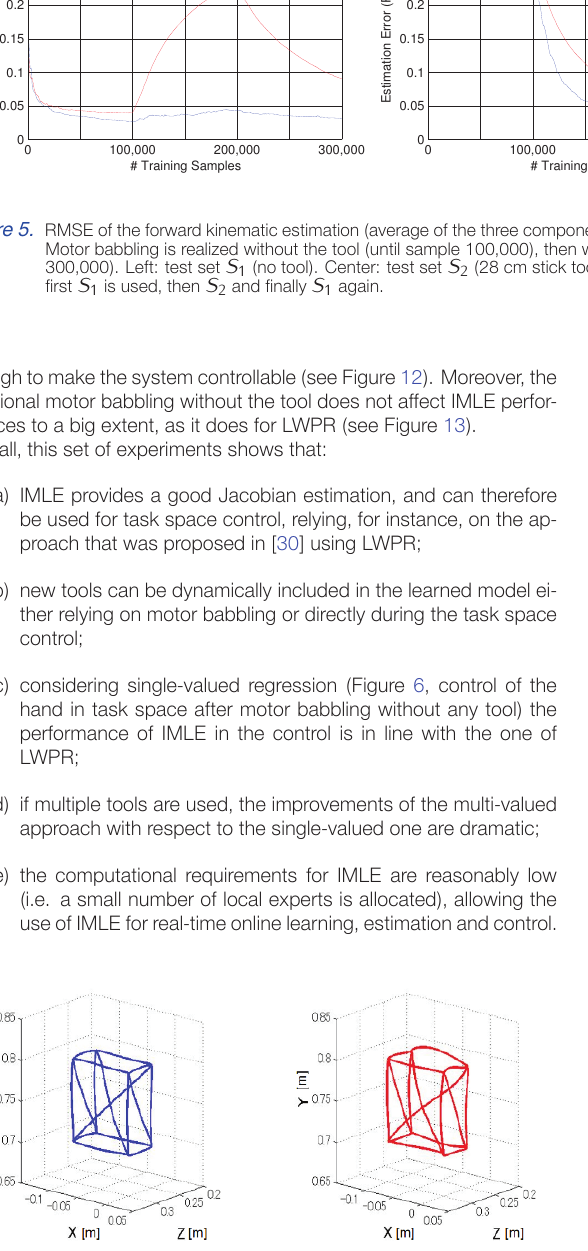
Figure 6. Task space trajectory of the hand during the test movement, after motor babbling without tool was performed. On the left: using IMLE. On the right: using LWPR.